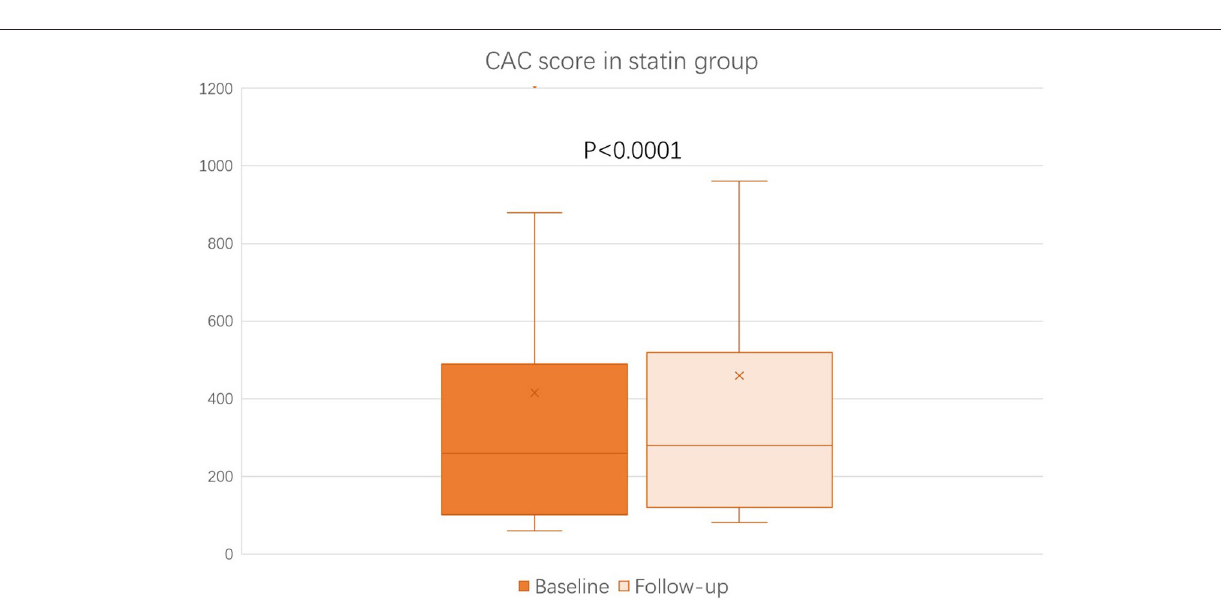
FIGURE 2 | Comparison of coronary artery calcium (CAC) score between the baseline and follow-up in the statin ( N = 28) group. CAC scores between baseline and follow-up were compared with the Wilcoxon signed-rank